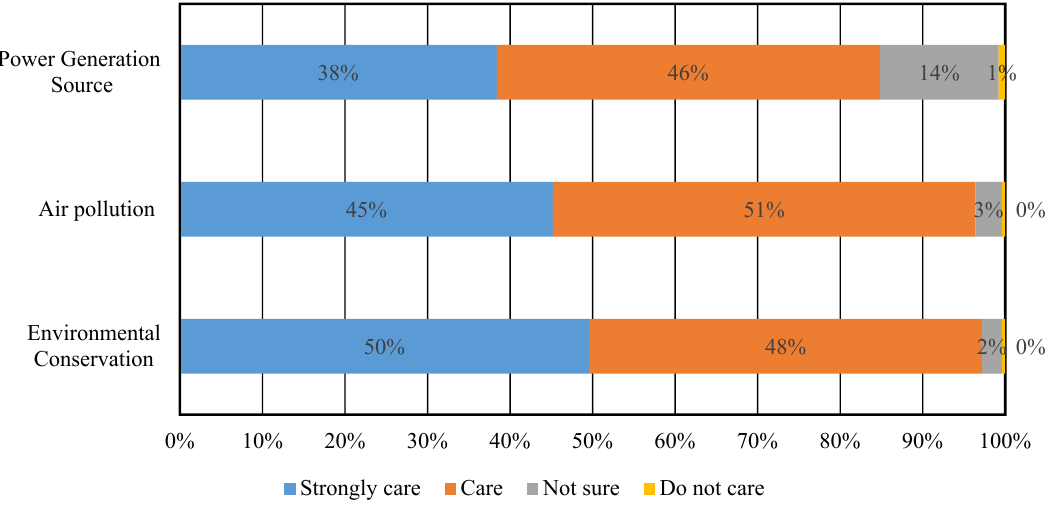
Figure 2. Perceptions on environmental conservation and power generation source.